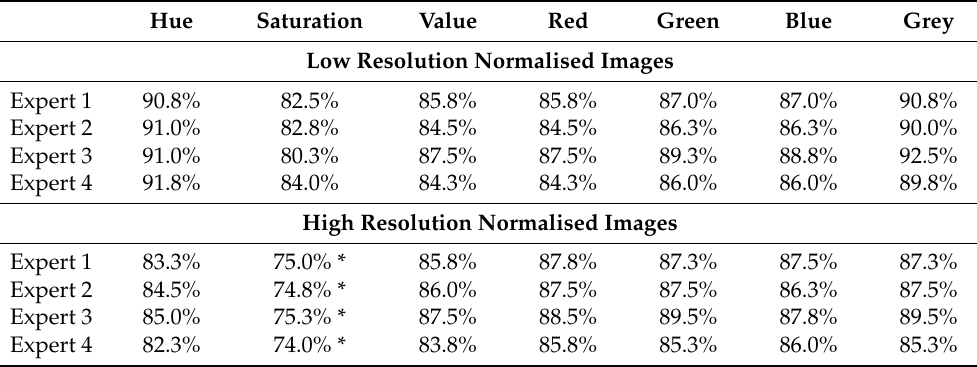
Table 3. Recognition rate referring to predictions provided by experts.